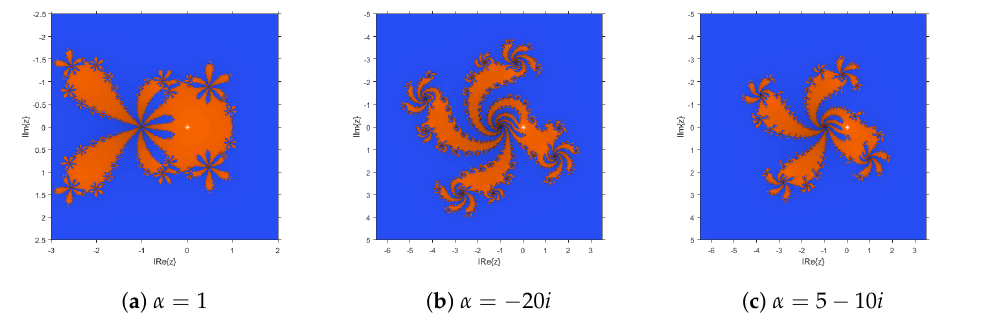
Figure 4. Stable performance of operator O α ( z ) .